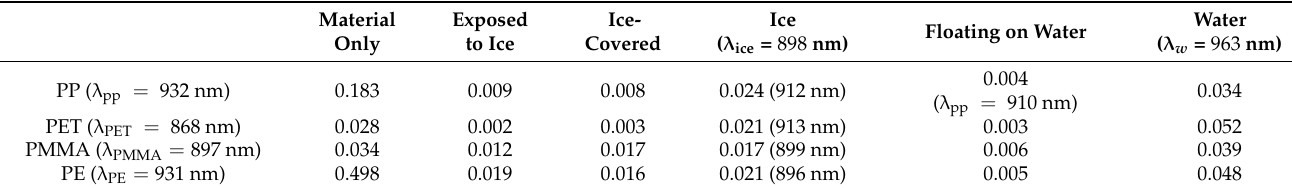
Table 2. The maximum of normalized reflectance NR max for representative peak wavelength of the plastic polymer in various